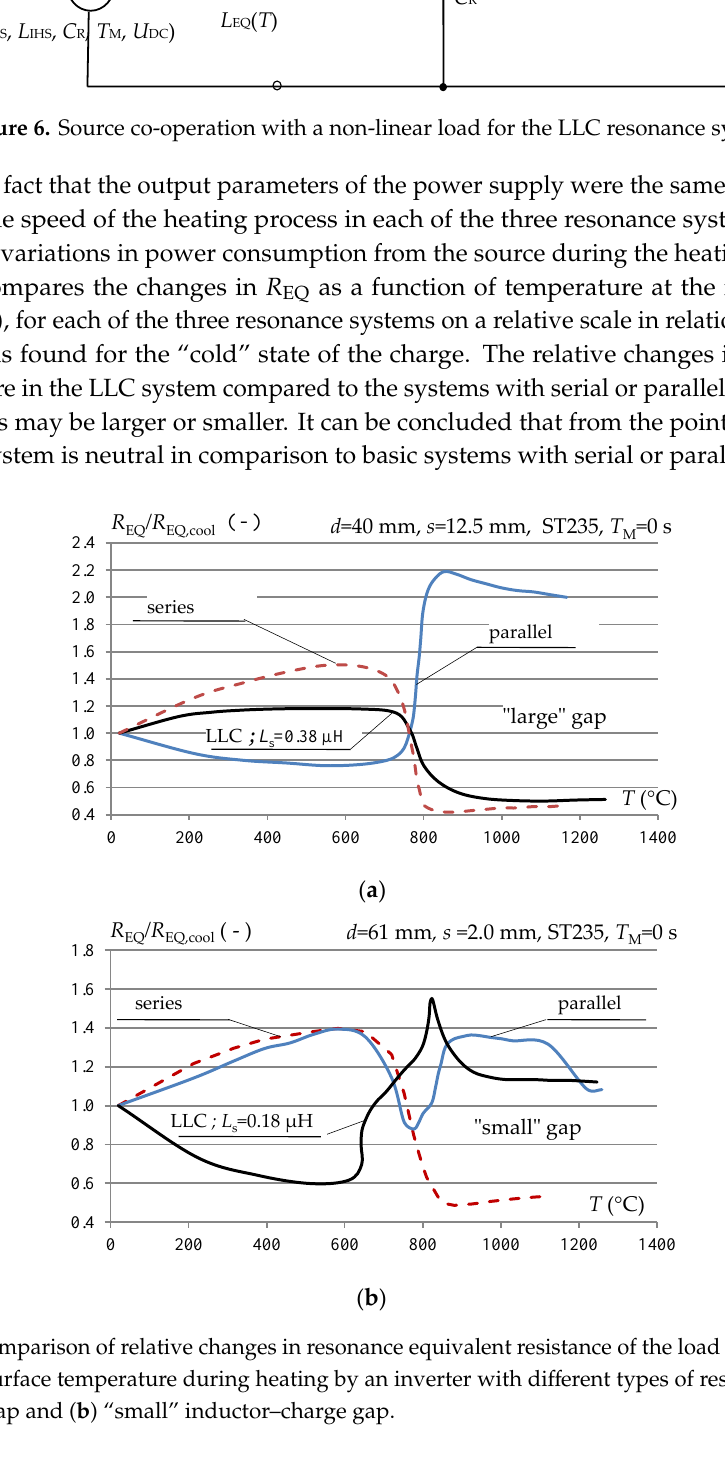
Figure 6. Source co-operation with a non-linear load for the LLC resonance system.